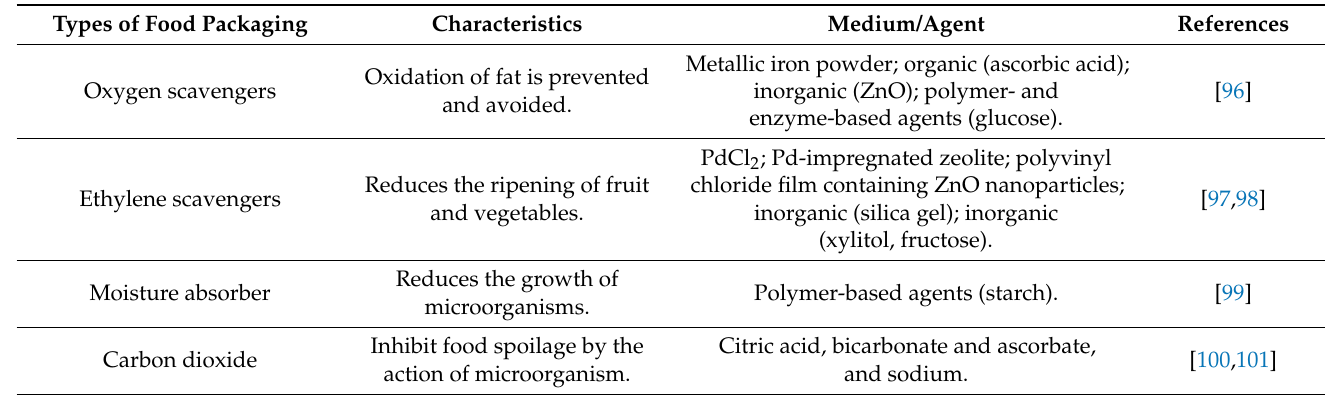
Table 5. Enhancement of food packaging (extract from Primozic et al. [11]). Types of Food